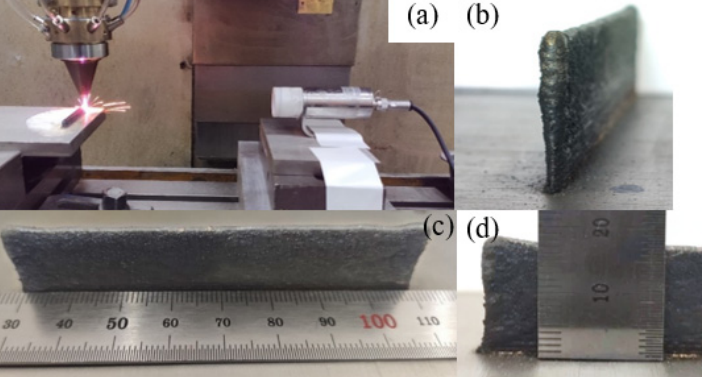
Figure 4. The 316L stainless steel thin-walled parts formed by laser cladding: ( a ) Processing process; ( b ) side morphology; ( c ) dimensions of thin-walled parts; ( d ) morphology of one end of the thin- walled parts.